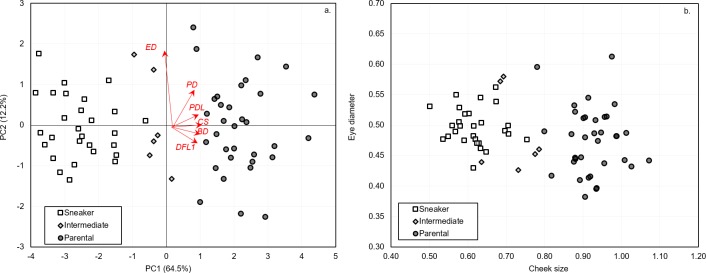
Biplot of the first two principal component axes (a) and scatterplot of cheek size vs. eye diameter (b) in Round Goby males. Based on 9 morphometric characters for sneaker morphs (n = 28), intermediates (n = 6) and parental morphs (n = 34; one parental was excluded from this analysis due to missing measurements).